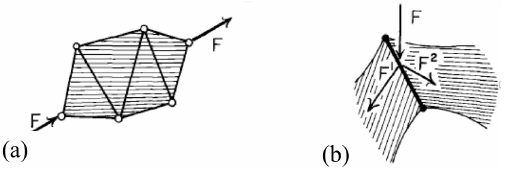
Figure 35. Loads being resolved along sheets ( a ) and at edges joining two sheets ( b ) [114]. Example 25. Figure 36 illustrates the polarity with a statically rigid octahedral framework going to a statically rigid hinged sheetwork on a cube, where each face is some statically rigid framework in the plane of the face. Note that we are really selecting from an equivalence class of all statically rigid sub-frameworks on vertices in the face. The equivalence is a result of a general substitution principle which is highlighted in the substitution principles in the next subsection.